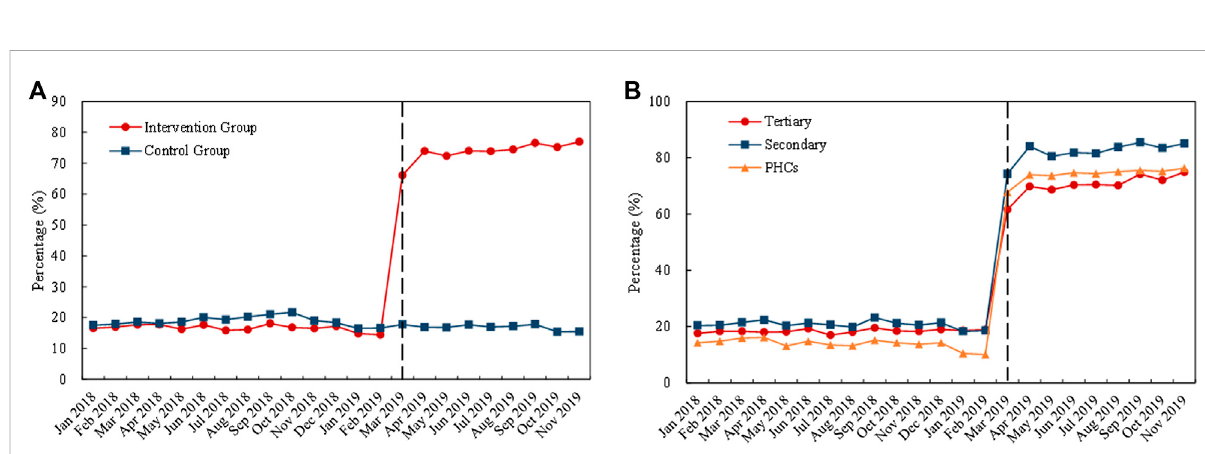
FIGURE 4 Trends in the volume proportion of bid-winning drugs during January 2018 to November 2019: (A) volume proportion of bid-winning drugs in the intervention group and control group (B) volume proportion of bid-winning drugs in intervention group by healthcare setting. Note : PHCs, primary healthcare